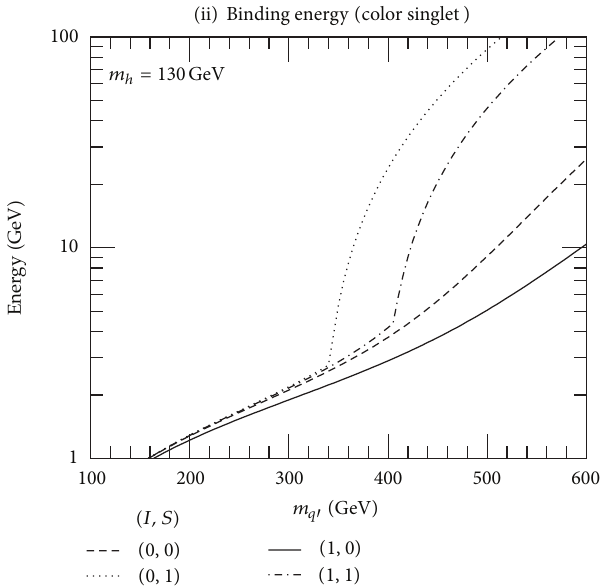
Figure 3: Variational binding energy of color singlet channels as the function of the heavy quark mass 𝑚 𝑞 ≡ 𝑚 𝑄